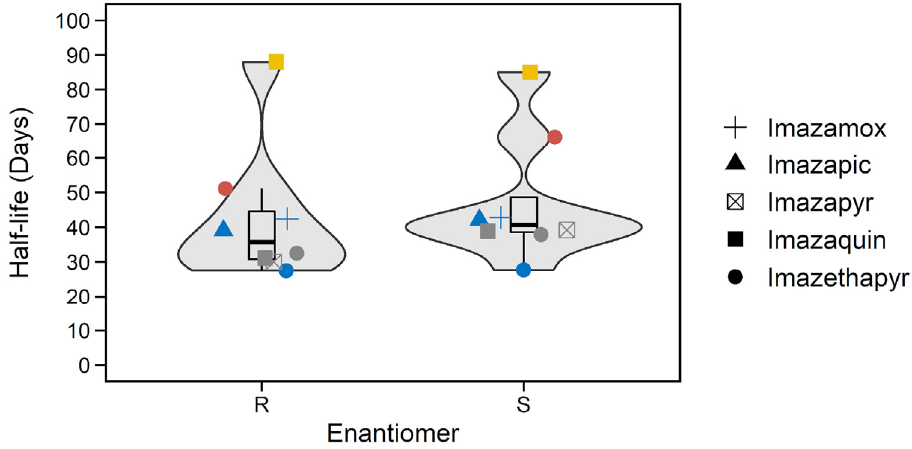
Figure 10. Half-life (days) of the S- and R- enantiomers of imidazolinones.